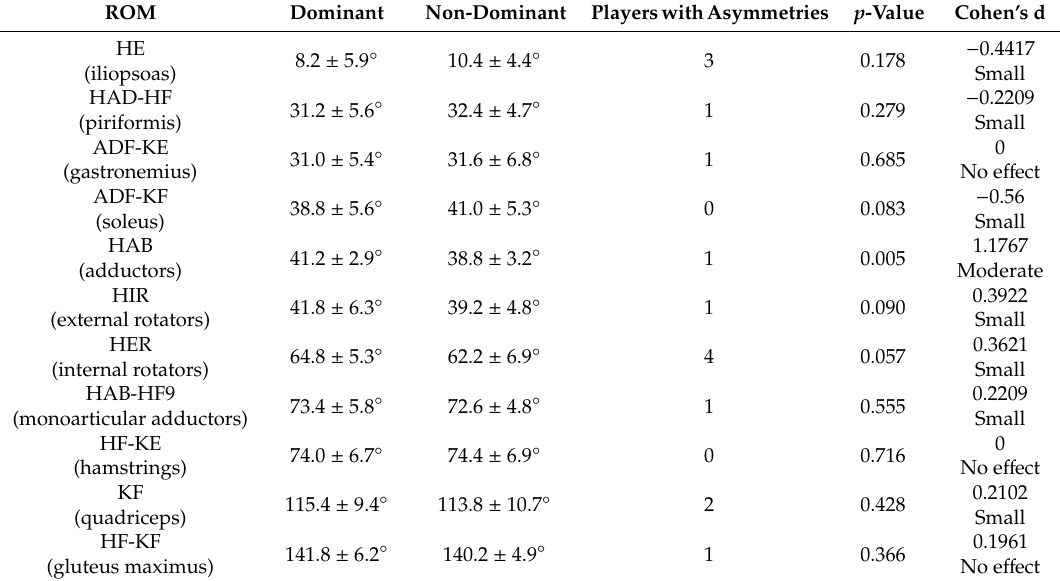
Table 4. Passive maximum range of motion values of 10 hockey players of the Spanish elite female national